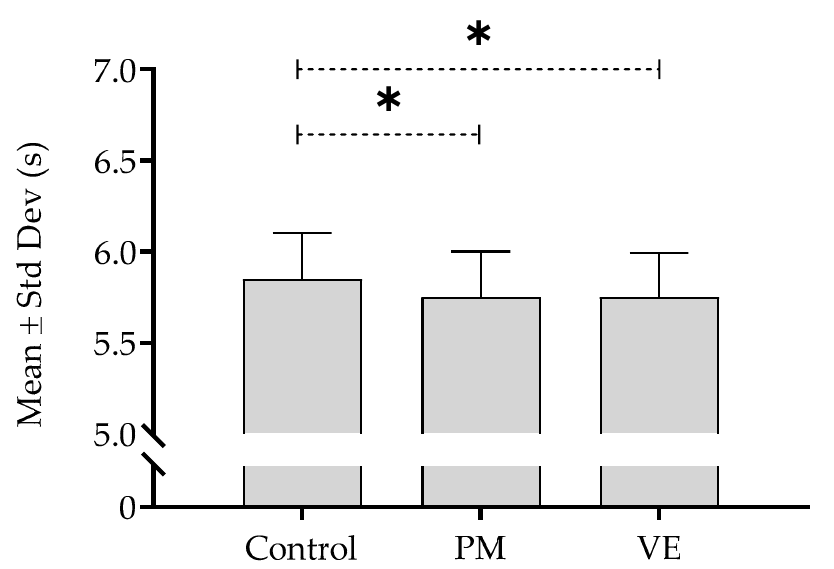
Figure 3. Descriptive statistics for peak time (PT) in three conditions (Control, PM—listening of the preferred music, VE—verbal encouragement), and post-hoc differences between conditions (* denotes the significance of p < 0.05). The FI did not differ significantly across three conditions (F-test = 0.16, p > 0.05; η 2 = 0.01) (Figure 4).